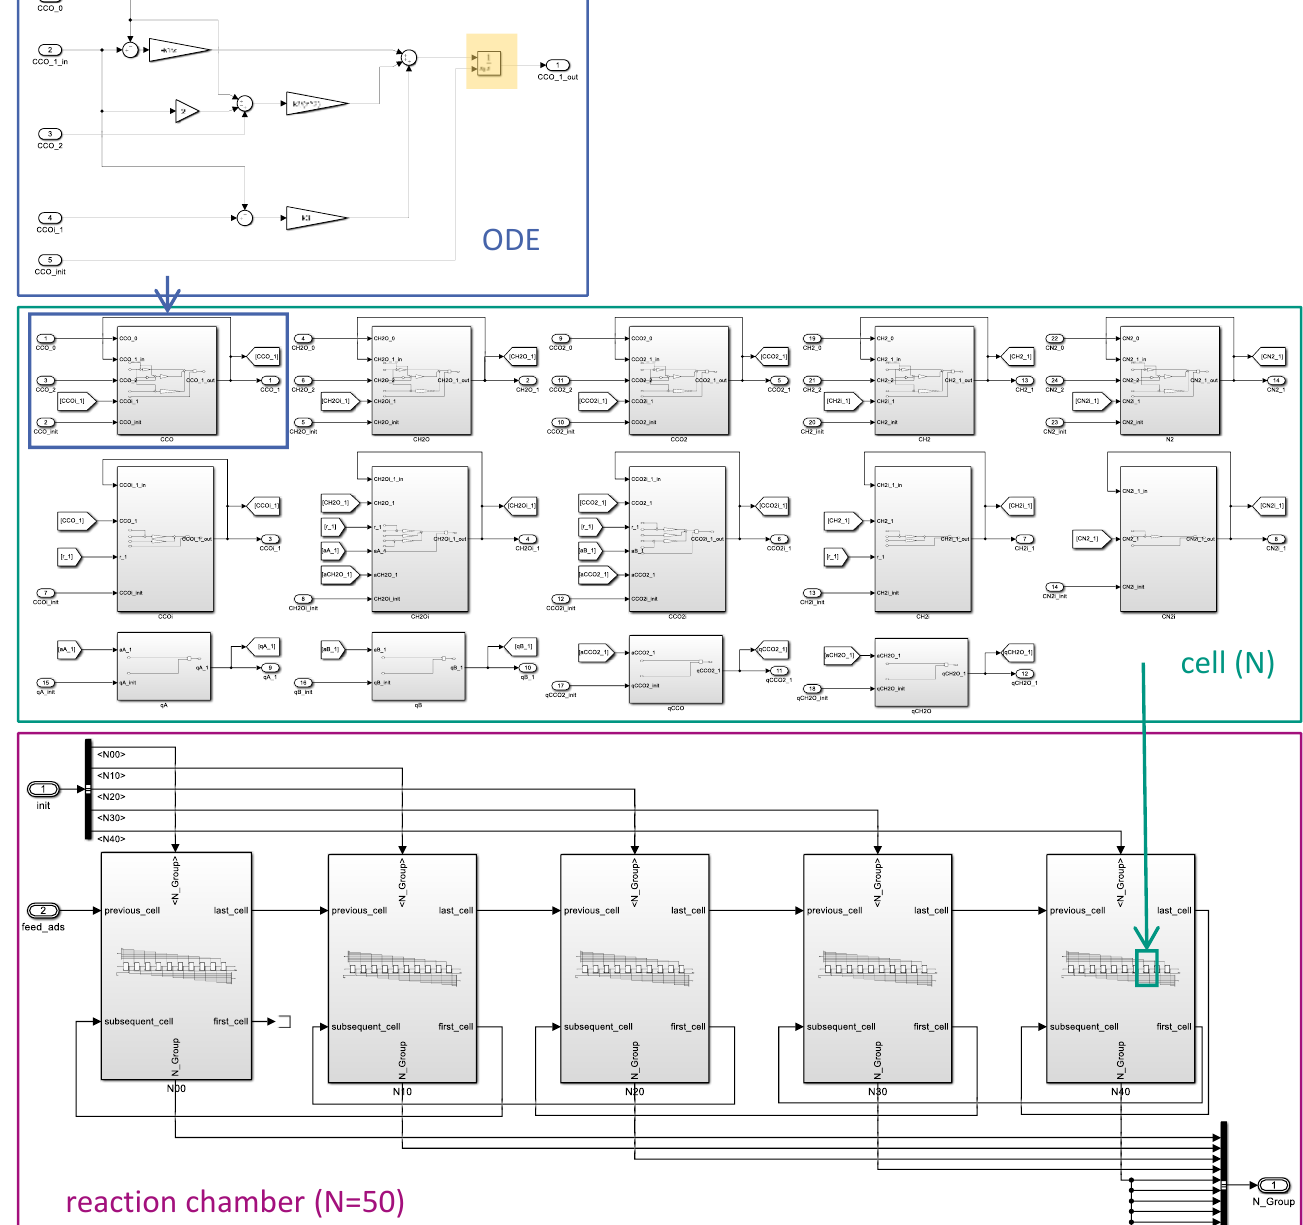
Figure 2. Bottom-up Simulink implementation of the model equations for one reaction chamber discretized analogous to MoL. Exemplary ODE implementation of the CO concentration in the bulk phase. The integrator block is marked in yellow. Fourteen ODEs arrange the cell subsystem; N (here: N = 50) cells form the reaction